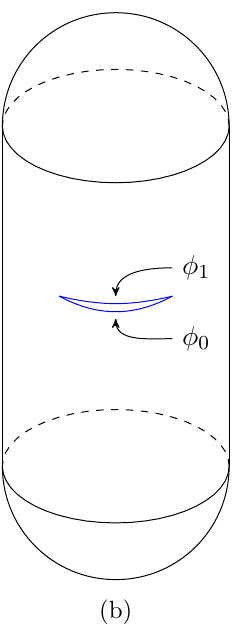
Figure 2. (a) The path integral given in equation (3.4) that prepares the state on the lower end of the cylinder is the Euclidean path integral, while the cylinder is the Lorentzian part of the path integral. Fixing the boundary condition on the open end of the cylinder to a field configuration φ 1 computes the amplitude that prepares the density matrix on the subregion R . The path integral at left for preparing the state Ψ( t ) has been doubled, and the two path integrals sewn together along R c . Fixing boundary | i conditions above and below the cut along R (shown in blue) computes the amplitude